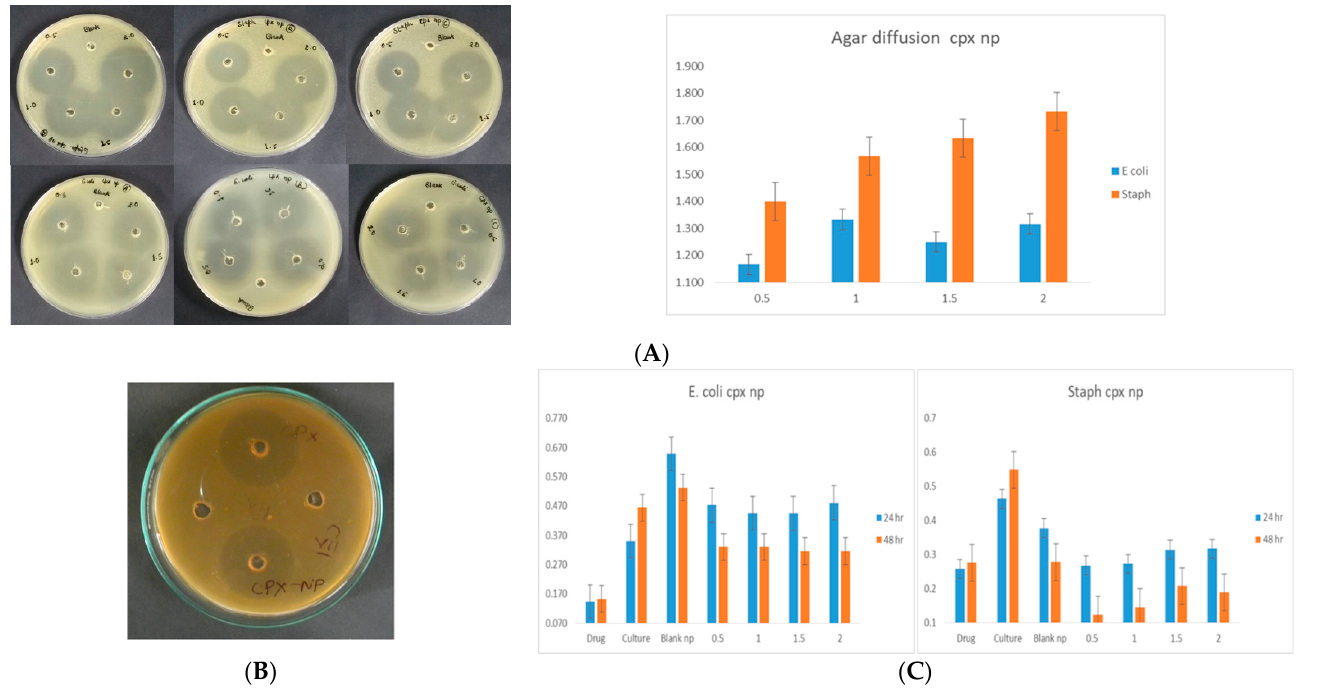
Figure 4. Antimicrobial activity of CPX-loaded nanoparticles against clinical isolate S. aureus and E. coli . ( A ) agar diffusion assay, ( B ) activity of equal amount of CPX and CPX-loaded nanoparticles, and ( C ) broth culture method at different doses of nanoparticles ( n = 3, ±SD).